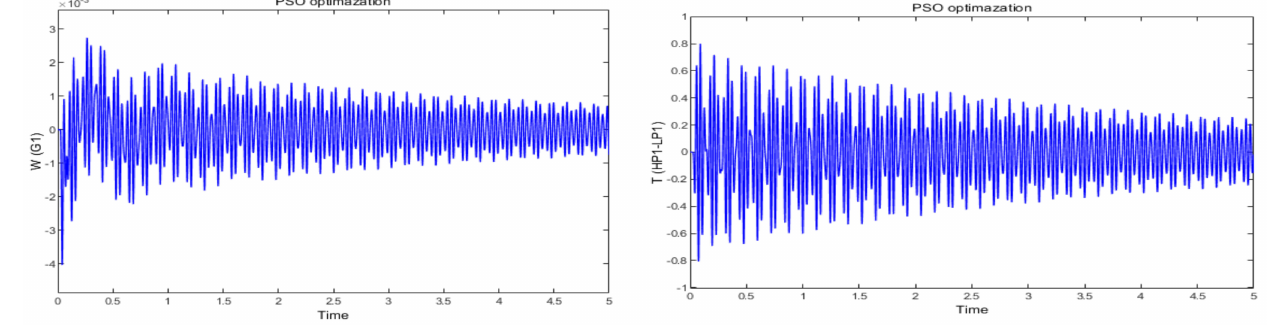
Figure 16. Damping of SSR with PSO method (synchronous generations and, turbine